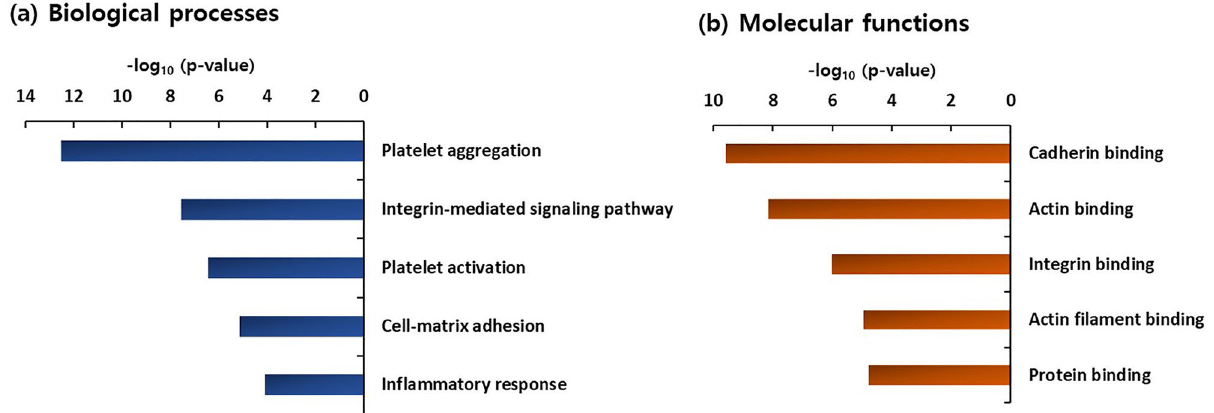
Figure 2. Top 5 biological process (BP) and molecular function (MF) terms ( a and b ), respectively, over- represented in proteins showing statistically significant increases ( P -value < 0.05, > 2.0-fold) by Gene Enrichment (GO)